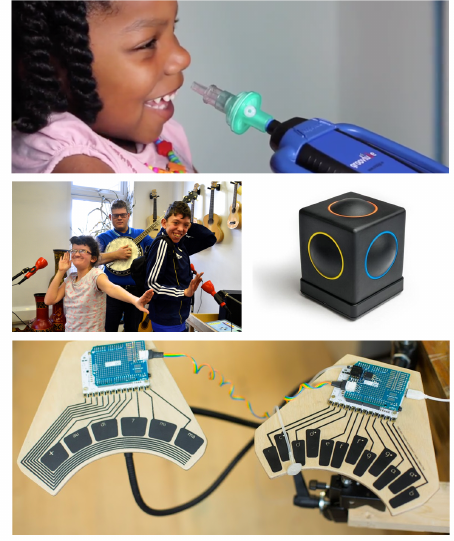
Figure 1. Examples of ADMIs. Top row: GroovTube [20]. Middle row: Left: SoundBeam [13], courtesy of Charlton Park Academy . Right: Skoog [15]. Bottom row: Touch Chord by Human Instruments